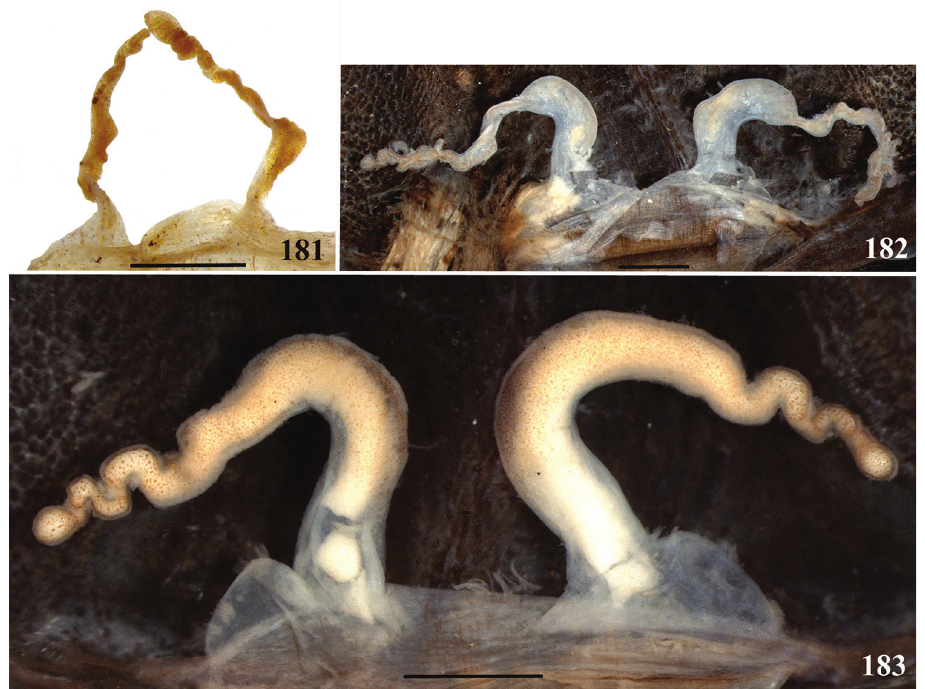
Figures 181–183. Avicularia hirschii Bullmer, Thierer-Lutz & Schmidt, 2006, spermathecae variation. 181 paratype, Oriente, department of Napo, Ecuador (SMF 57126) 182 Estação Ecológica Rio Acre, Assis Brasil, state of Acre, Brazil (MNRJ 06911) 183 Senador Guiomard, state of Acre, Brazil (MNRJ 06912). Scale bars = 1